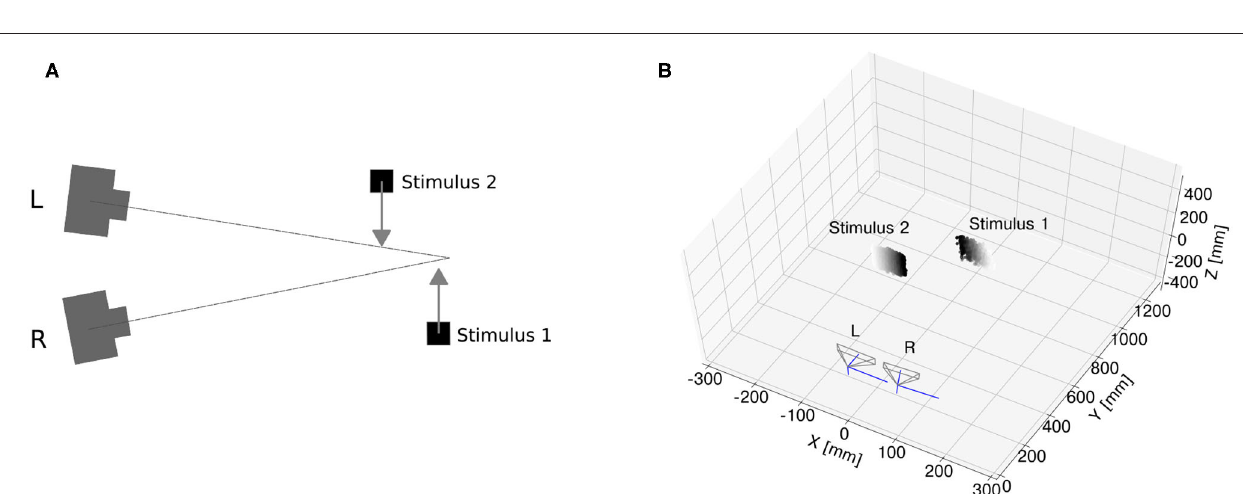
FIGURE 5 | Synthetic dataset: the neural activity is depicted as a temporal image, with gray levels representing synchronous activation in time (A) . Two spike trains were generated to simulate the activity of event cameras in response to two edges moving in opposite directions at constant depth levels (B) . Input binocular time series and expected activation over time of disparity neurons are shown as temporal images.